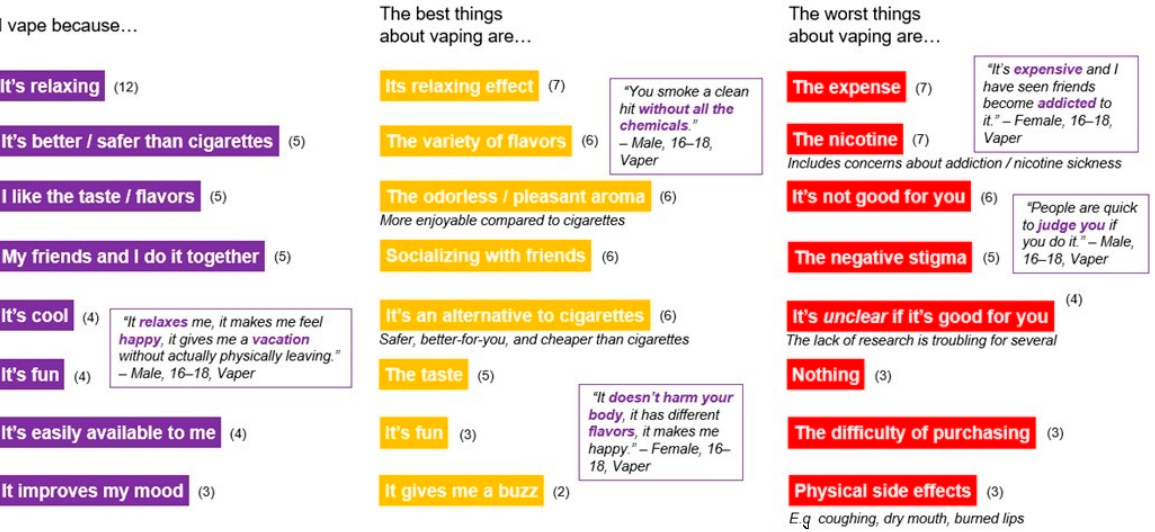
Figure 1. Associations with Vaping. Note: Numbers in parentheses represent the number of participant comments related to the theme.